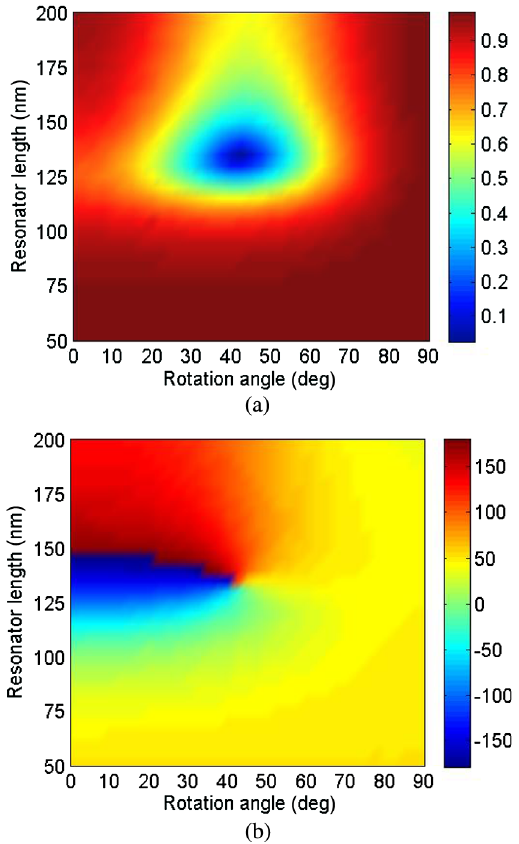
FIG. 12. Full-wave unit-cell characterization result: variations in (a) magnitude and (b) phase of S 11 for different resonator lengths and rotation